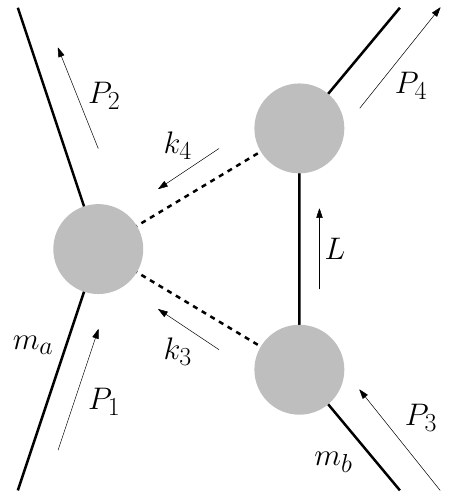
Figure 2 . The triple-cut diagram for b -topology triangle cut. The a -topology diagram is obtained by exchanging the labels of particles a and b